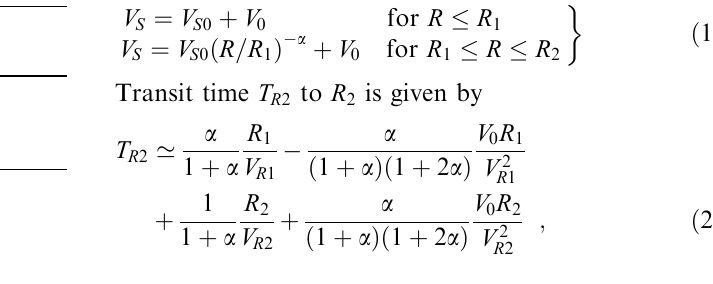
Table 4. Interplanetary shock speeds deduced from MHD simulation by Smith and Dryer (1990) Vi (km/s) (cid:115)